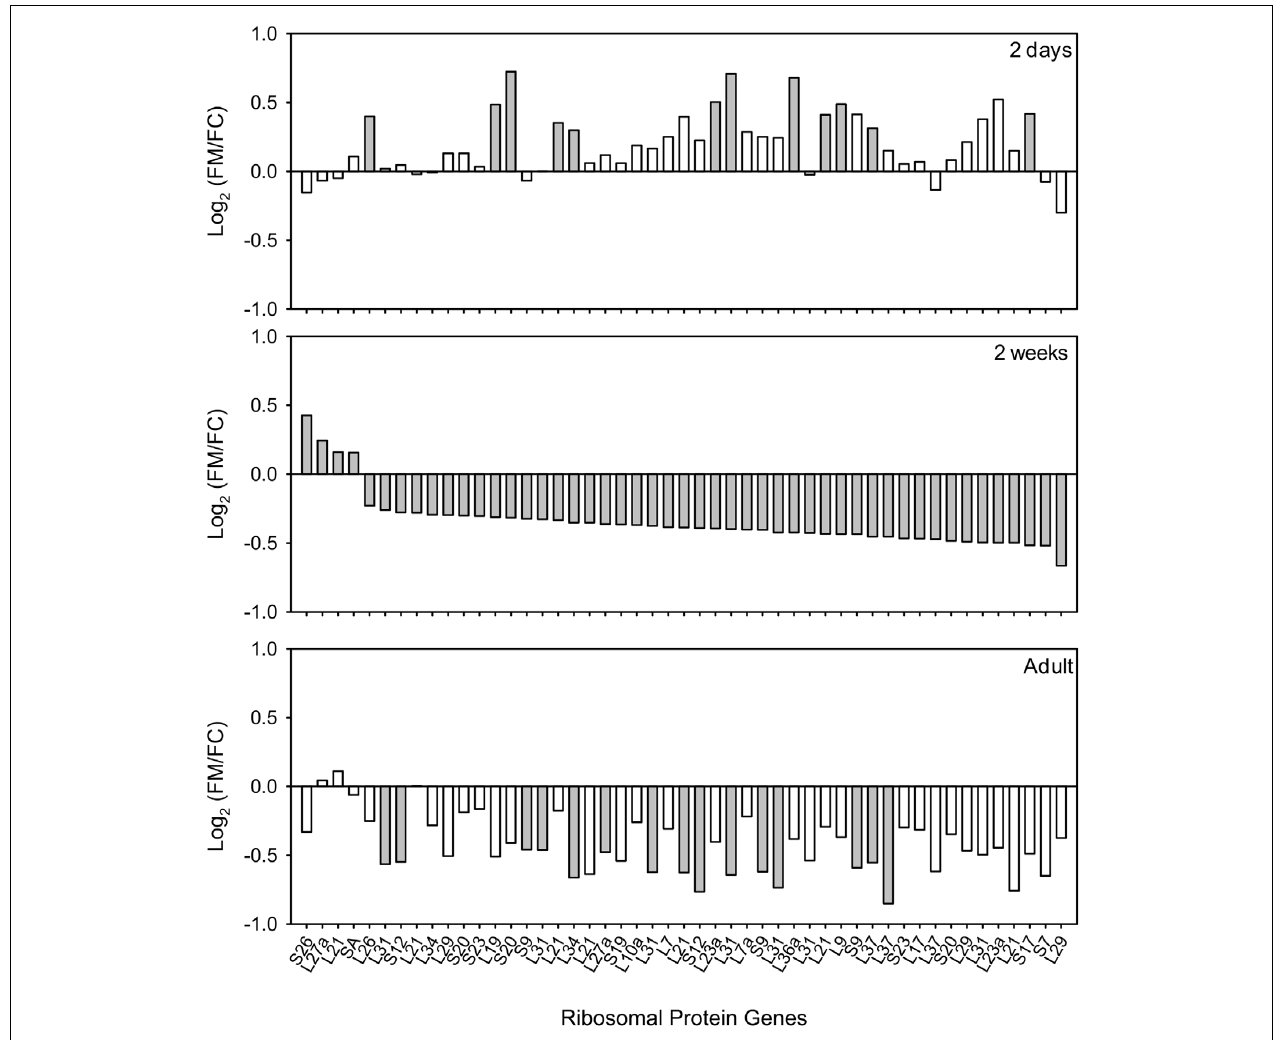
in adults (lower panel).The ratio of the genes is expressed as Log2(FM/FC), where FM and FC are the normalized intensities of gene expression in the molsidomine and control groups, respectively. Significant differential expression is indicated by a closed bar, non-significant differential expression by an open